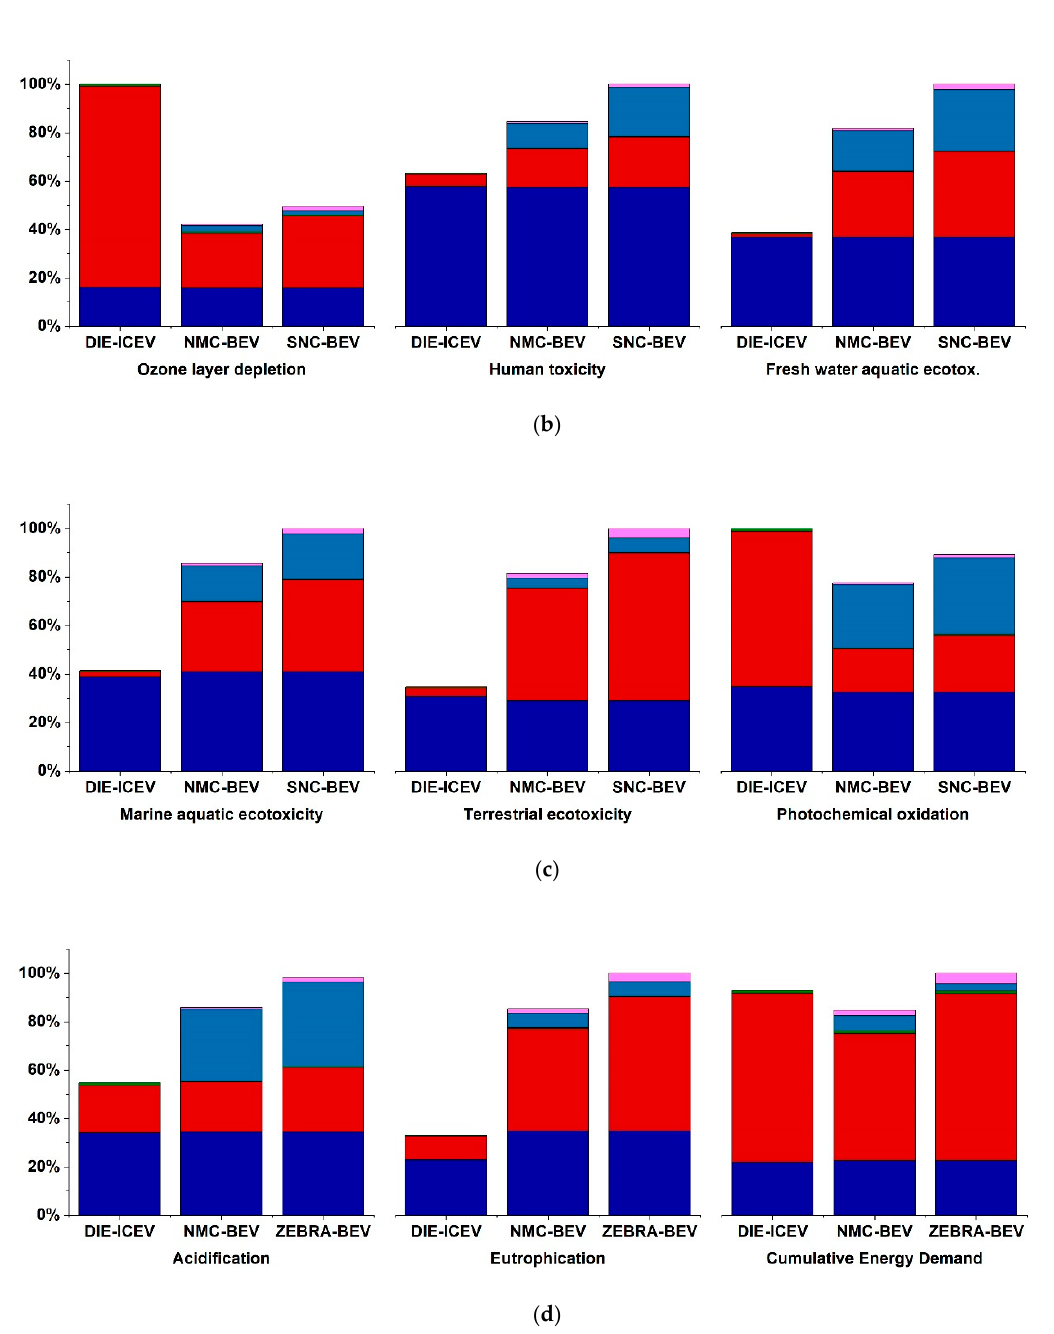
Figure 8. ( a – d ) The LCA of the conventional diesel vehicle (DIE-ICEV), the electric vehicle with two NMC111 battery packs (NMC-BEV), and the electric vehicle with two ZEBRA battery packs (ZEBRA-BEV). The contributions from the production and use-phase of the battery and vehicle and from vehicle maintenance are highlighted for each impact category; no EoL is considered here.